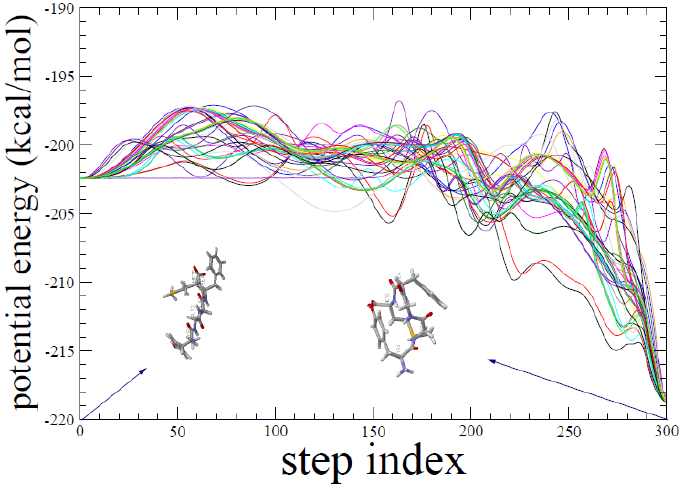
Figure 1. Fifty independent potential-energy variations for met-enkephalin are shown along the action-derived molecular dynamics (ADMD) step index. The same initial and final conformations are used for all ADMD simulations. The potential-energy variations clearly show the existence of multiple pathways. There exist many alternative folding routes that connect the extended and compact peptide conformations. Two conformations used as inputs for ADMD simulations are shown. The initial (final) conformation shown at j = 0 (300) is prepared by applying local energy minimization to the fully-extended (compact) structure. We observe that one of the ADMD trajectories is of almost constant potential energy in the first half of the trajectory. In this part, the kinetic energy is rather high. It should be noted that the total energy (sum of kinetic energy and potential energy) is conserved along all ADMD pathways.